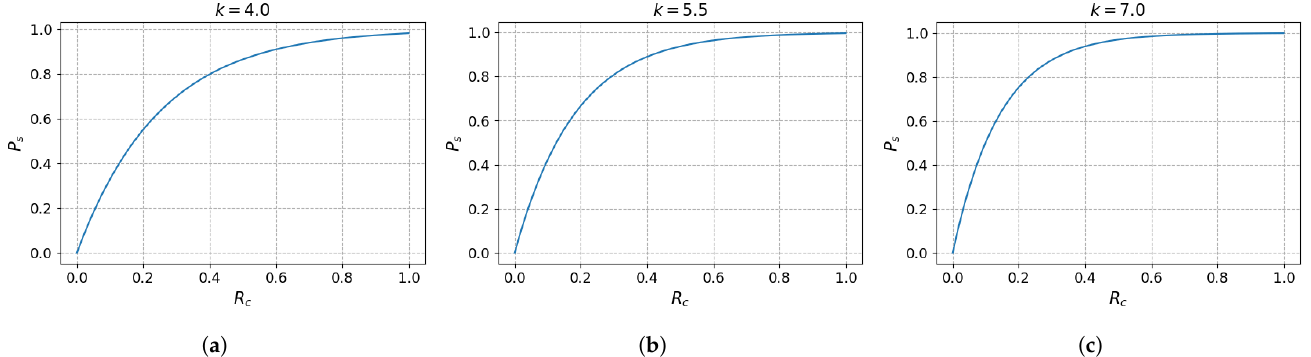
Figure 4. Graph of P S according to k value. It determines each layers pruning rate. ( a ) is P s at k = 4.0. ( b , c ) shows P s at k = 5.5 and k = 7.0, respectively. When the current compression rate R c is small, almost all layers are selected in the previous step. In this case, a small value of pruning rate P s prevents the vanishing of large weights. Unlike this, when R c is large, only a few layers which has many small weight value are selected. Thus, the large value of P s helps to significantly reduce the redundancy and reach the target compression